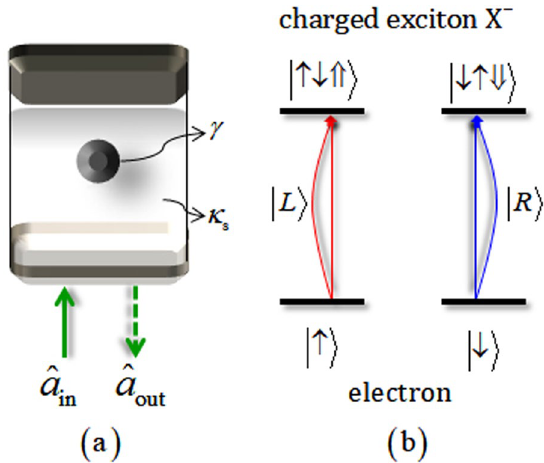
Figure 1. ( a ) A singly charged QD inside a single-sided cavity interacting with a photon, with side leakage rate ( κ s ) and decay rate ( γ ) of X − . ( b ) By the spin selection rule in the QD, the photon | L 〉 (| R 〉 ) drives the interaction as ↑ → ↑↓ ( ↓ → ↓↑ ), where ↑ ≡ + ↓ ≡ | − 1/2 are the spin states of the excess electron, and represent heavy-hole spin